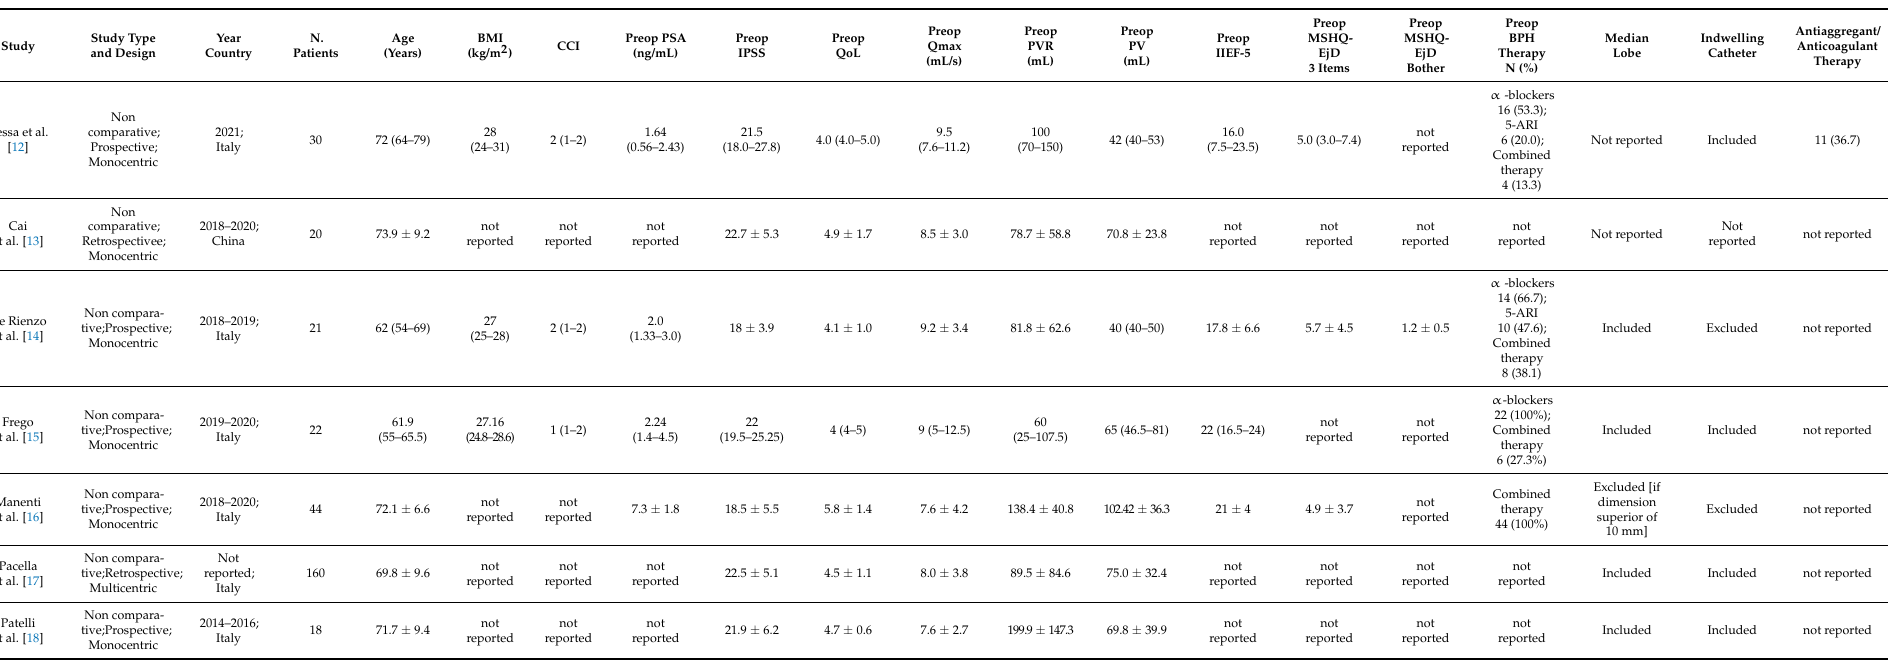
Table 1. Key characteristics of studies on Transperineal Laser Ablation (TPLA) of prostate included in this review and patients’